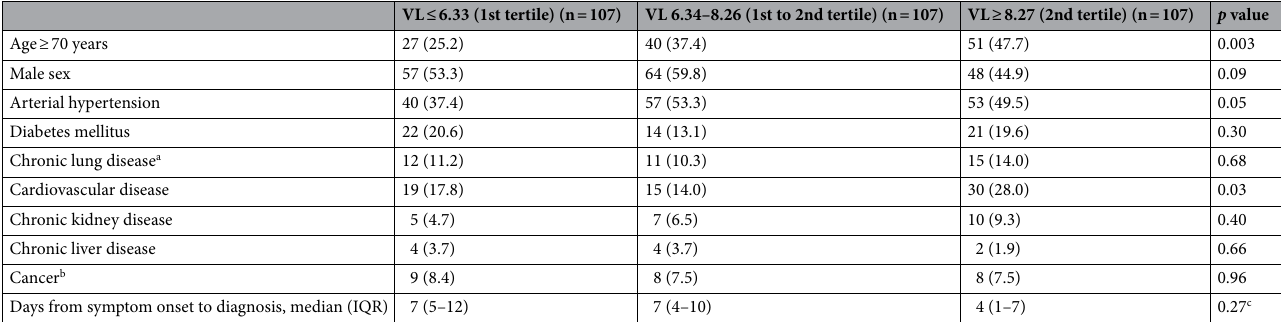
Table 3. Demographics, comorbidities, and days from symptoms onset to diagnosis of 321 patients with COVID-19 stratified according to nasopharyngeal viral load (VL, log 10 copies/mL). Data are presented as n (%) unless otherwise indicated. a Chronic obstructive pulmonary disease, obstructive sleep apnea, or asthma. b Active solid or hematologic malignant neoplasms. c Viral load ≤ 6.33 (1st tertile) vs. viral load ≥ 8.27 (2nd tertile).